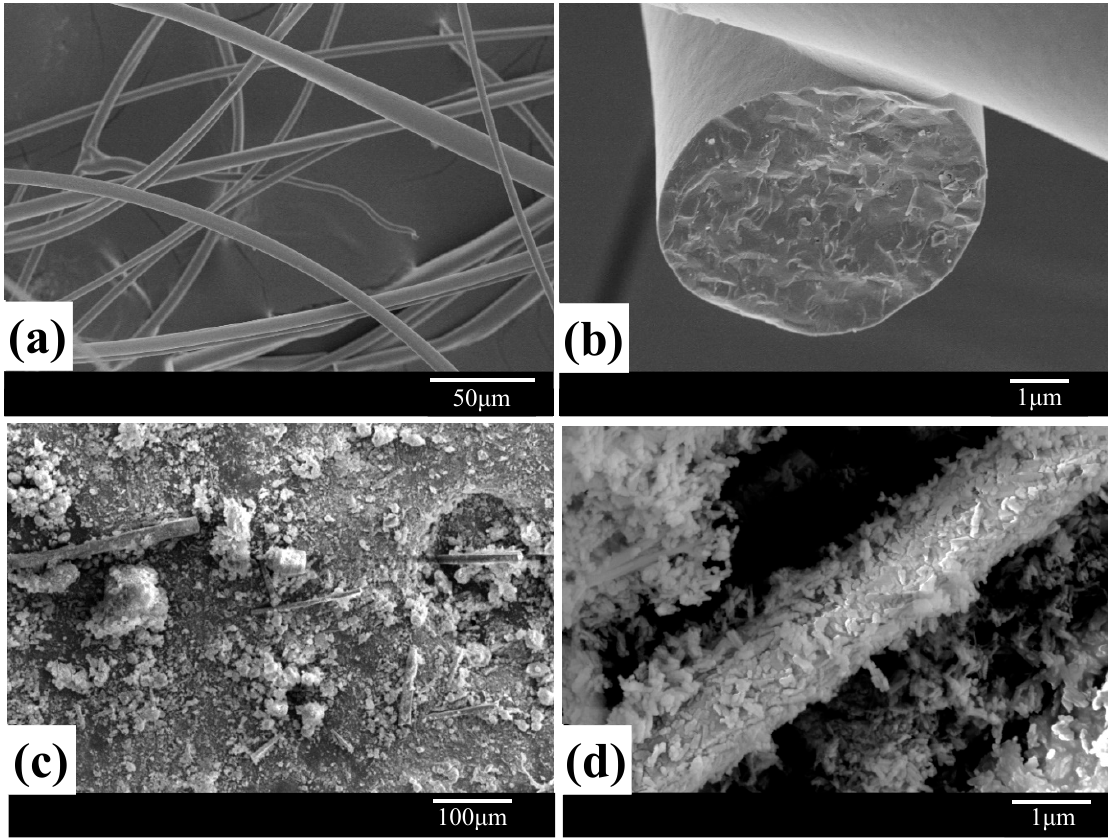
Figure 2. The morphology of mullite fibers: ( a , b ) untreated; ( c , d ) after hydrothermal treatment.